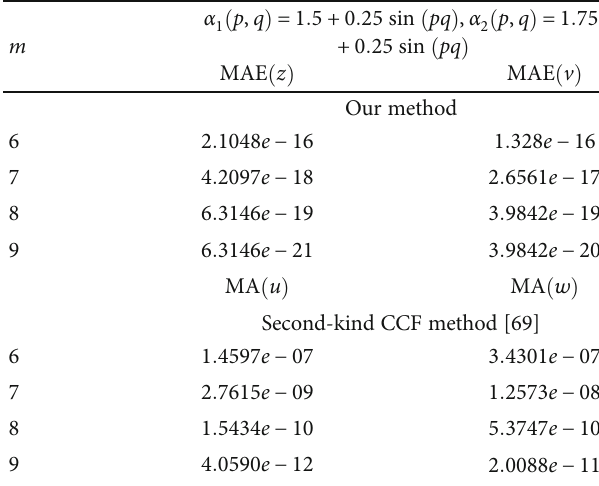
Table 3: Comparison of the numerical results for Example